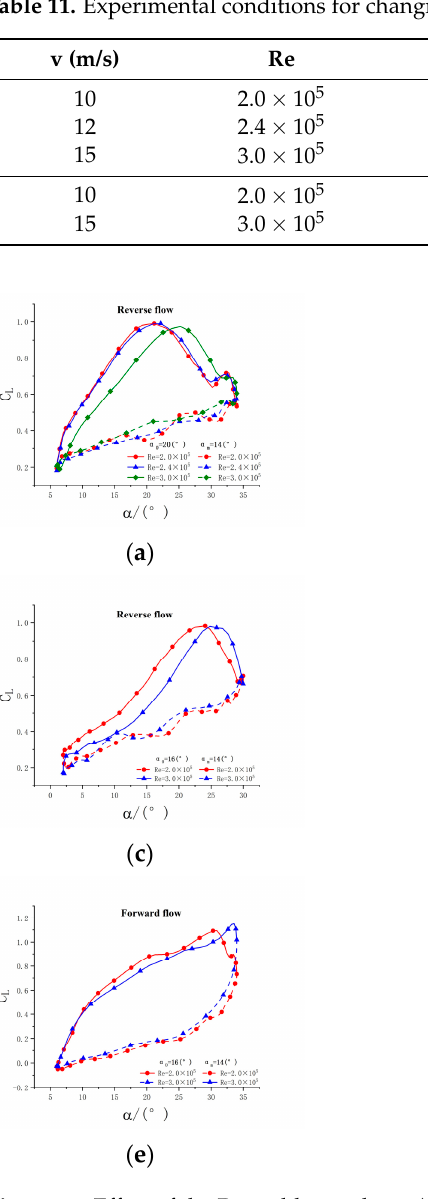
Figure 19. Effect of the Reynolds numbers. ( a ) C L , ( b ) C m , ( c ) C L , ( d ) C m , ( e ) C L , ( f ) C m